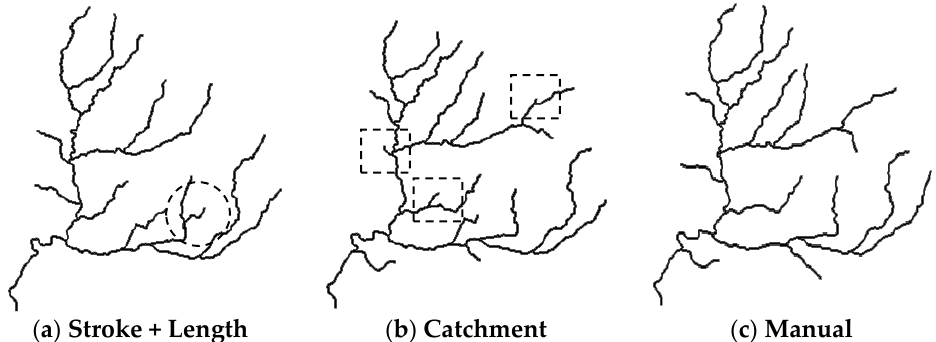
Figure 8. Generalized networks by three methods for dendritic case. ( a ) Stroke + Length; ( b ) Catchment; ( c ) Manual.